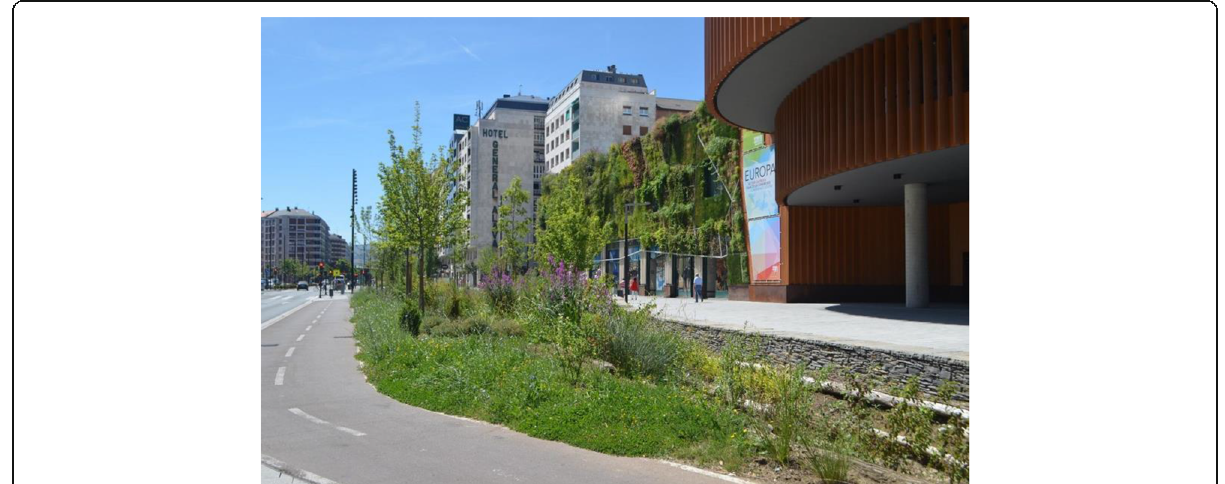
Fig. 1 Living stream opposite the Palace of Europe in Vitoria-Gasteiz, Spain. Source: Agata